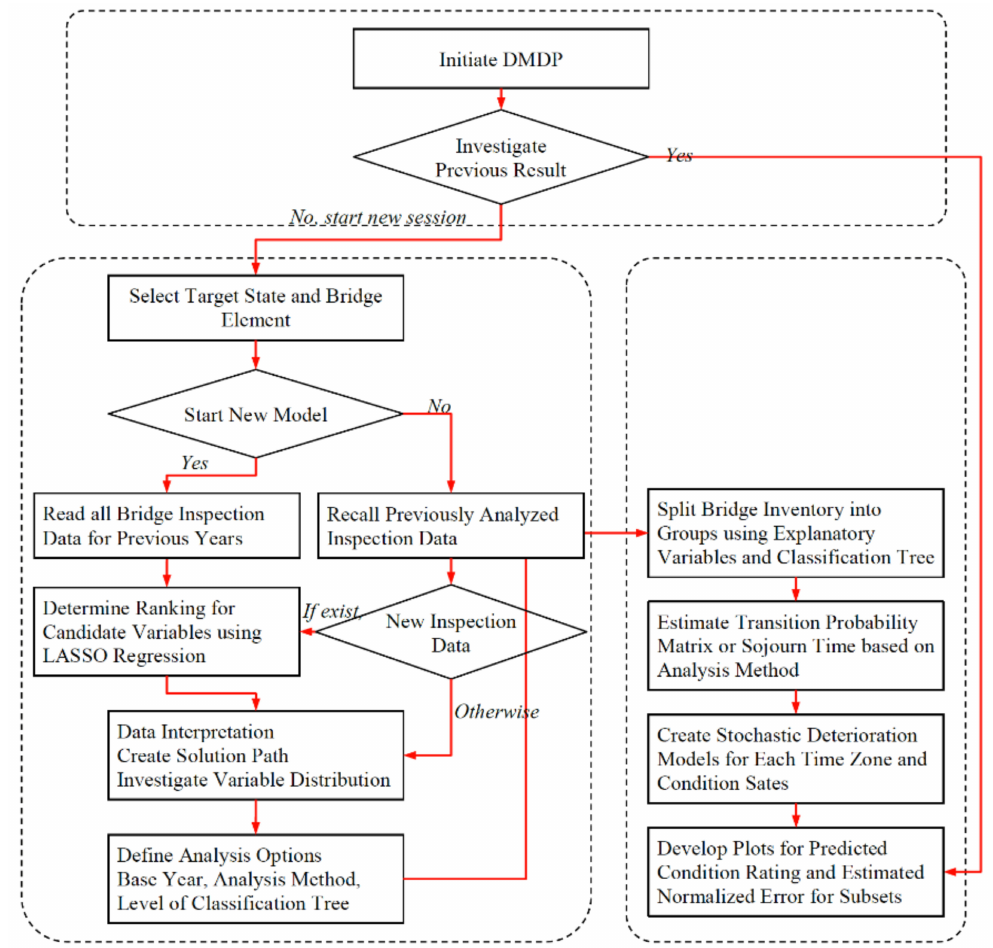
Figure 1. Flowchart for Deterioration Model Development Package